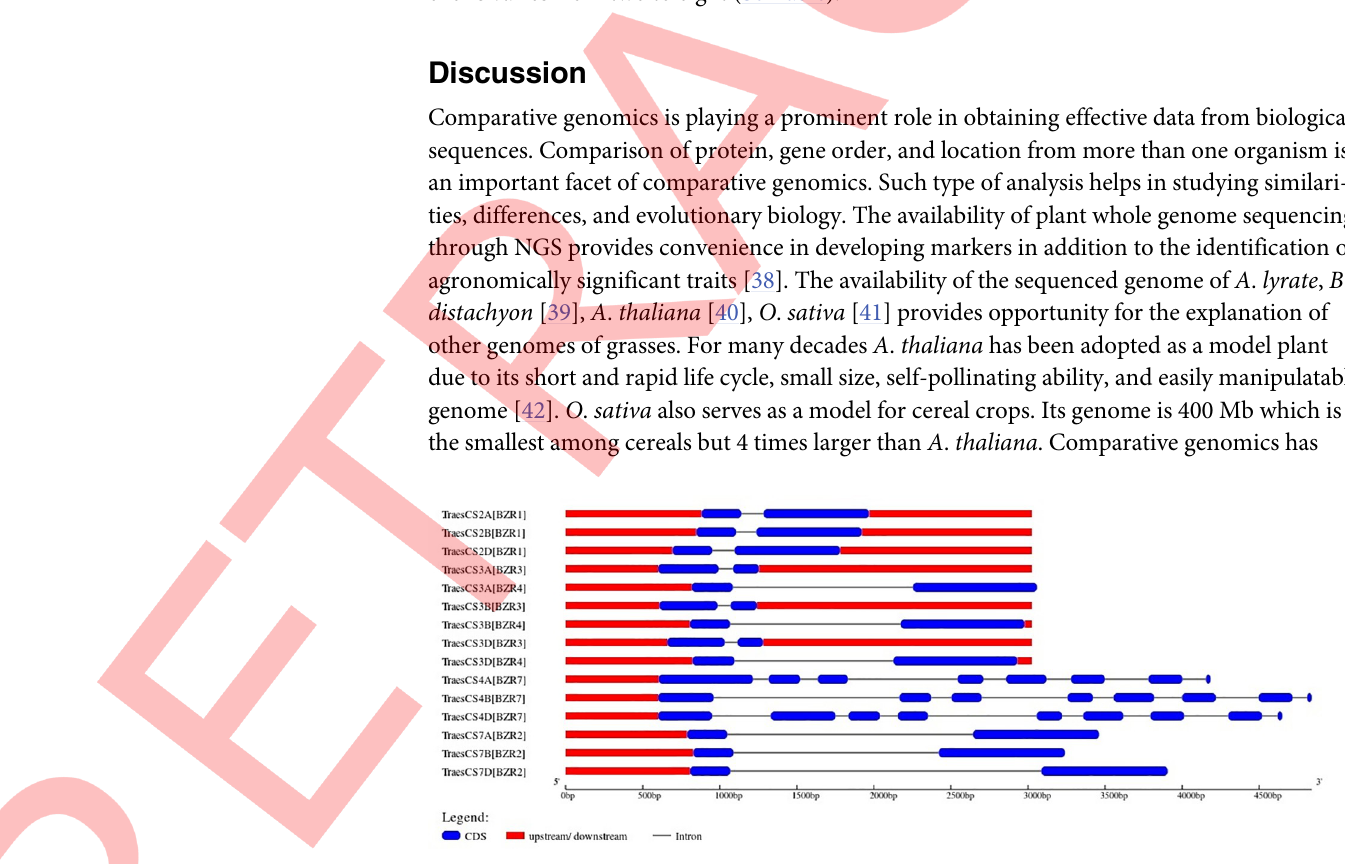
Fig 4. Conserved domain analysis of BBR/BPC.